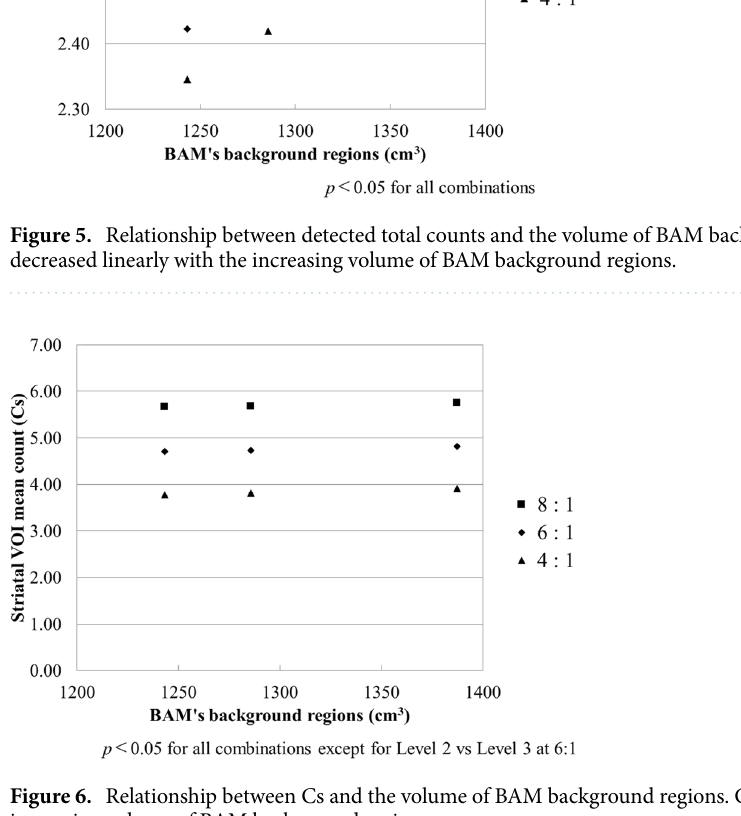
Figure 6. Relationship between Cs and the volume of BAM background regions. Cs decreased linearly with the increasing volume of BAM background